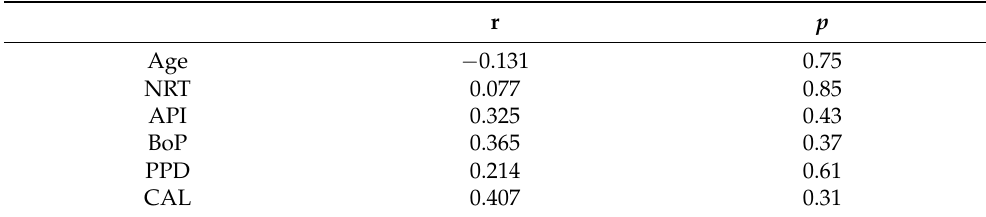
Table 10. Correlations between IL-18 gingival expression and the selected clinical parameters in the control